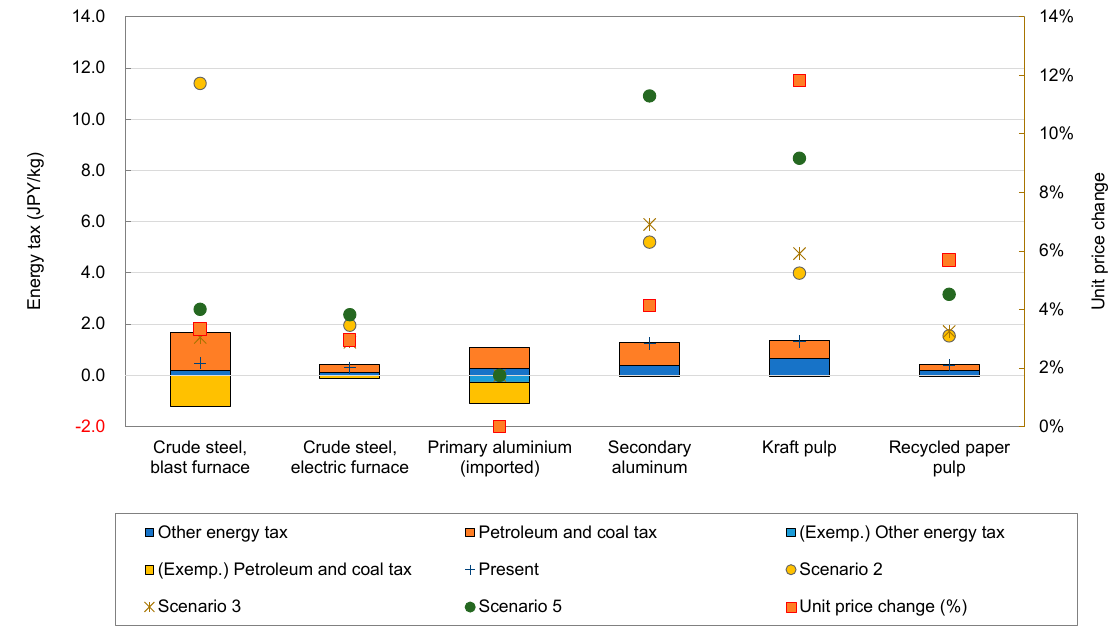
Figure 6. Changes in product taxes and product prices in materials under different taxation scenarios. The bar graphs show the present taxation breakdown. The percentage change in product prices compares the present with Scenario 5.